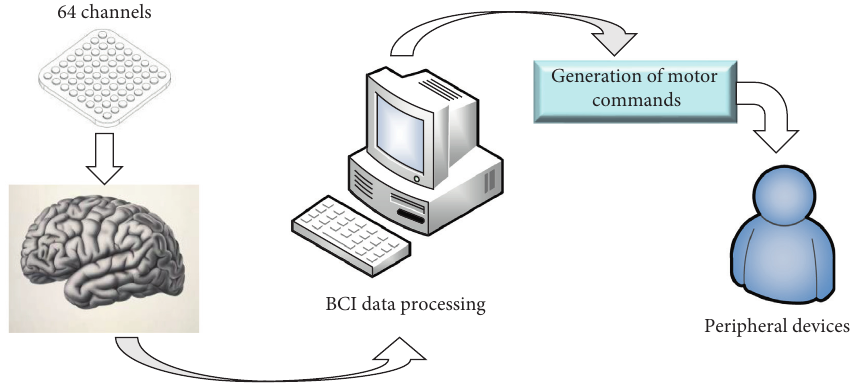
Figure 1: The main procedure of the BCI